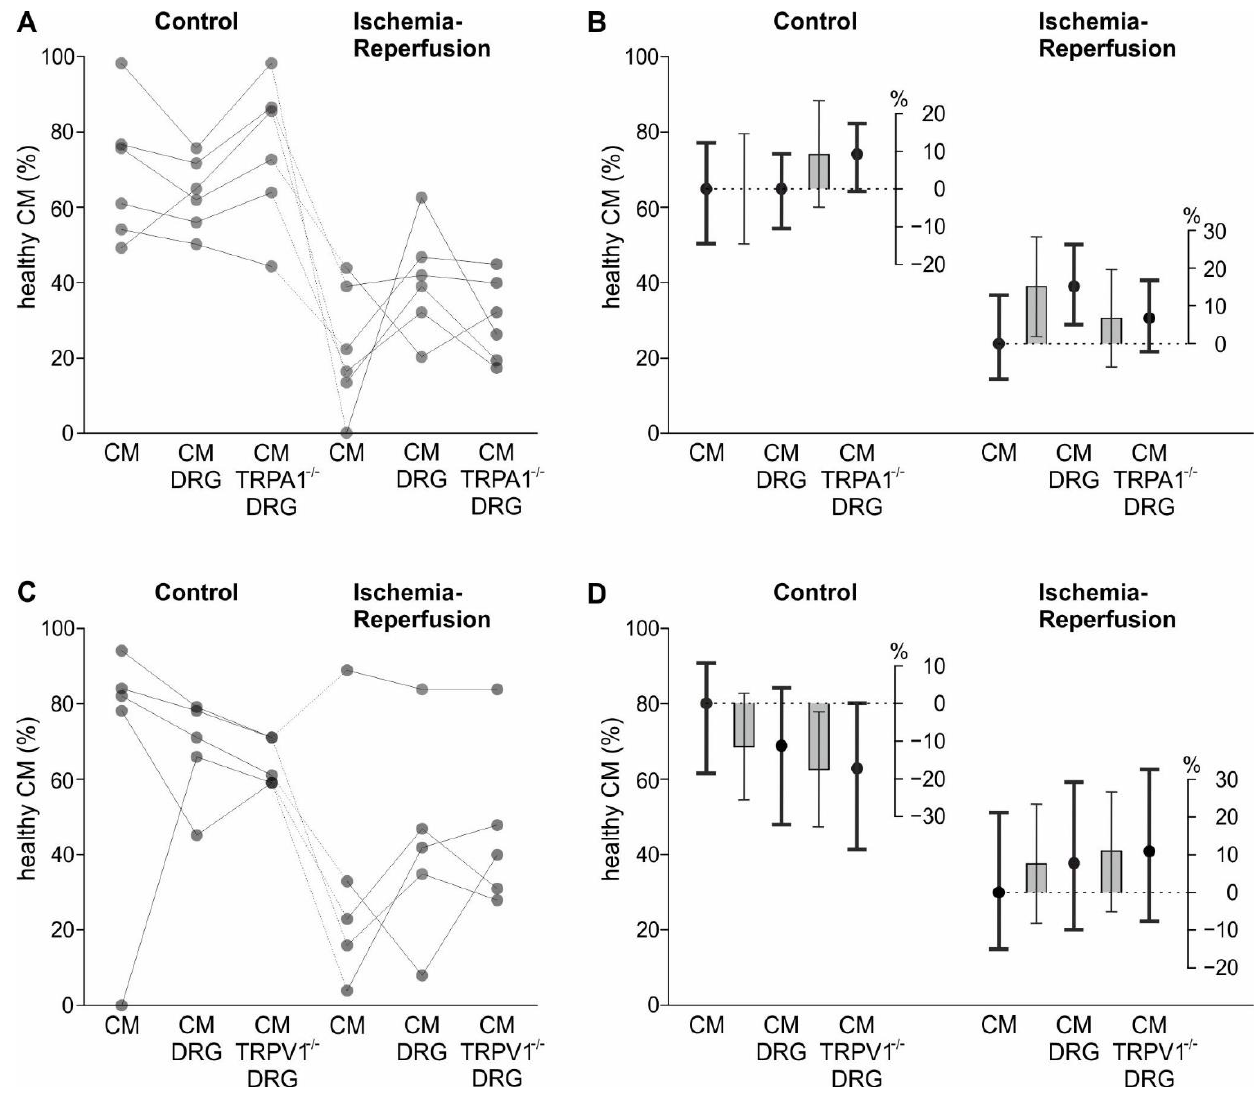
Figure 4. Involvement of sensory neuron TRP channels in increased CM ischemia-reperfusion tolerance. ( A , C ) Percentage of healthy CM at the end of the cellular model for IR, with 2 h of mimicked ischemia and 0.5 h mimicked reperfusion. Every dot represents the mean of one experiment, and those experiments conducted in parallel are connected. Experiments were conducted with WT sensory neurons from dorsal root ganglia (DRG) and with TRPA1 −/− sensory neurons ( n = 6 experiments). The WT sensory neurons are contained in the 14 independent experiments of Figure 3A,B. ( B ) Estimated survival probabilities for each group are shown as black dots ± 95% CI, estimated differences are shown as grey bars ± 95% CI. ( C ) Independent experiments, conducted with WT or TRPV1 −/− sensory neurons. ( n = 5 in panel C). Again, the WT sensory neurons are contained in the 14 independent experiments of Figure 3A,B. ( D ) Survival probabilities and estimated differences as in panel C.